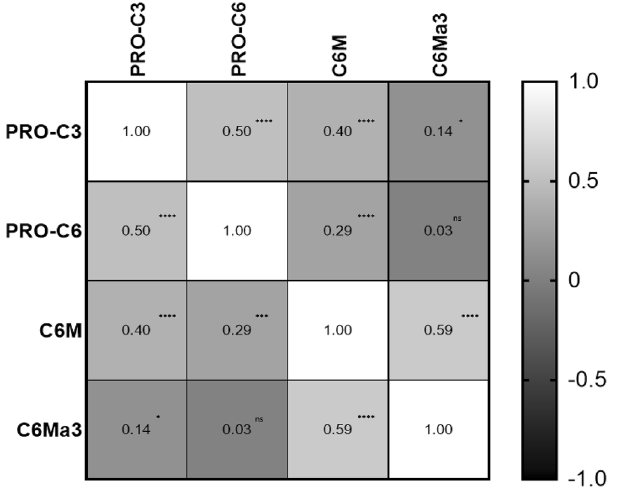
Figure 4. Correlation between biomarker levels where compared pairwise and evaluated by the nonparametric Spearman correlation coefficient. ns, not significant. * p < 0.05. ** p < 0.01. *** p < 0.001. **** p < 0.0001. A p < 0.05 was considered